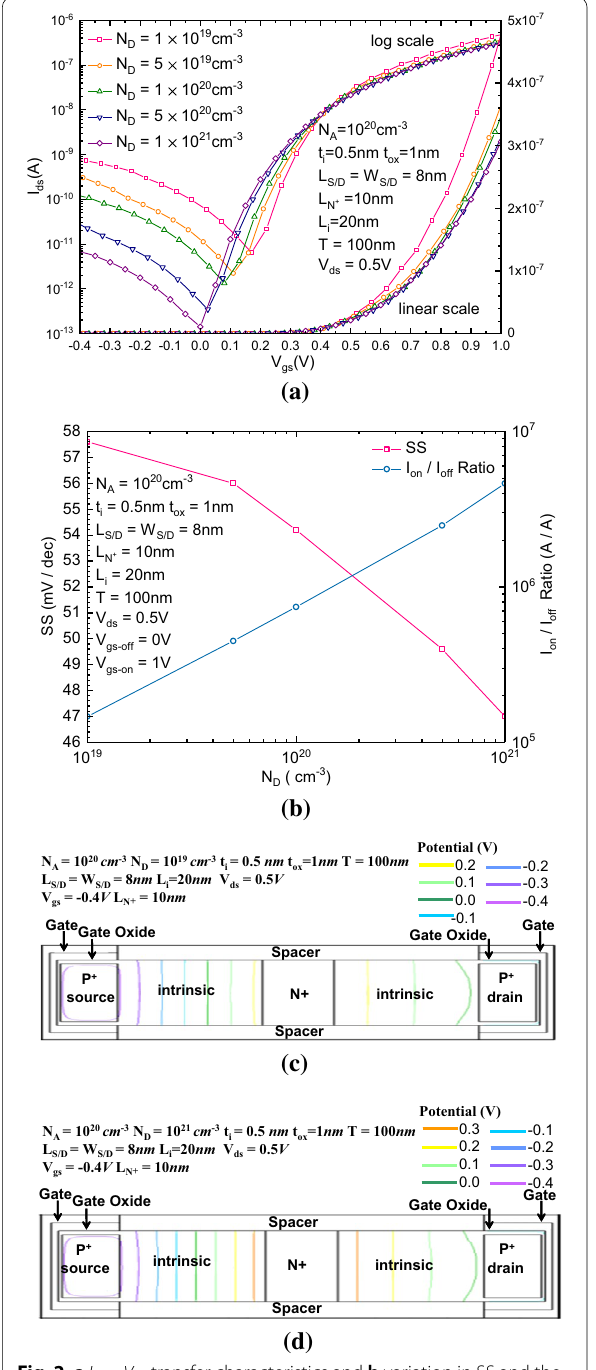
Fig. 2 a I ds − V gs transfer characteristics and b variation in SS and the − I I on off ratio of the proposed B‑TFET with different biased 2‑dimensional potential distribution with c N D and d N